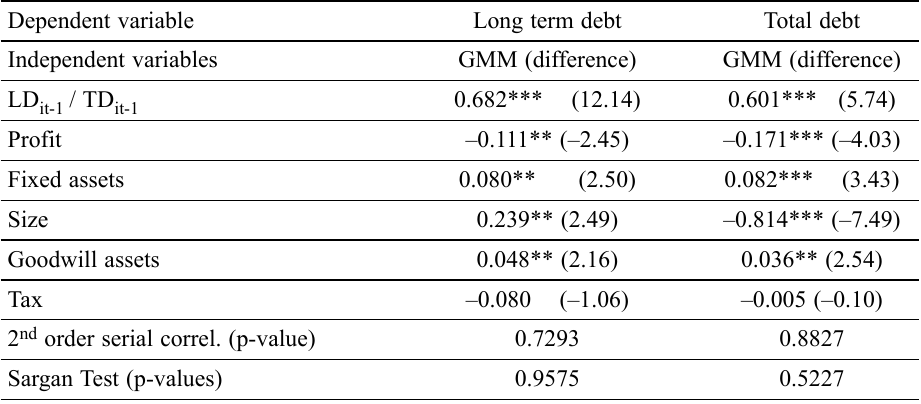
Table 3. Generalized method of moment estimates (two-step difference